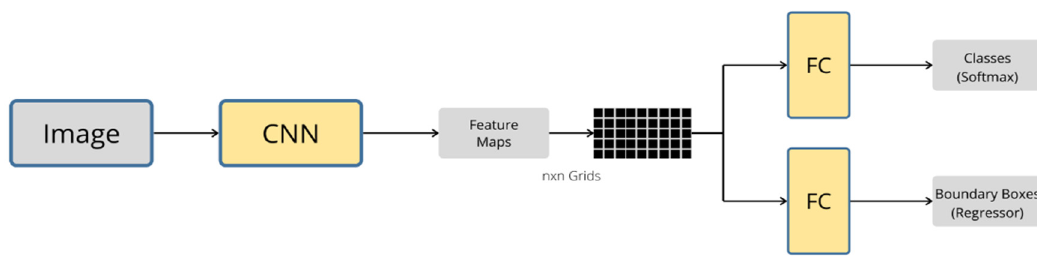
Figure 14. The architecture of “you only look once” (YOLO) algorithm.